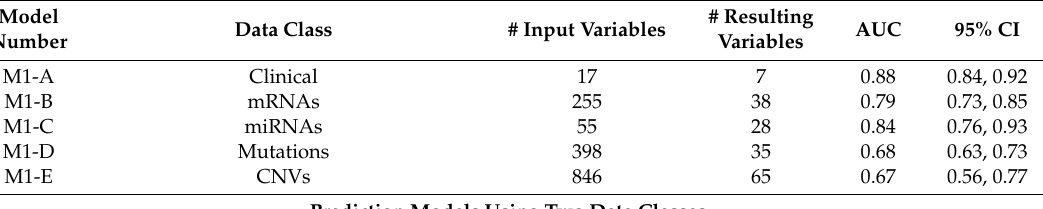
Table 2. Prediction models for levels of risk using diverse clinical, pathological and molecular data. Models that included only 1 data class used all variables selected with the cross-validation analysis (input variables: 17 clinical features, 255 mRNAs, 55 miRNAs, 398 somatic mutations and 846 CNVs). The Lasso analysis selected only the most informative resulting variables for the prediction process: 7 clinical features, 38 mRNAs, 28 miRNAs, 35 somatic mutations, and 65 CNVs. For prediction analysis using more than one data class, we used the resulting variables. Model performances were measured by AUC and their 95% confidence interval (CI). Models with the best performance are marked with * Prediction models using only one data class. # Number of